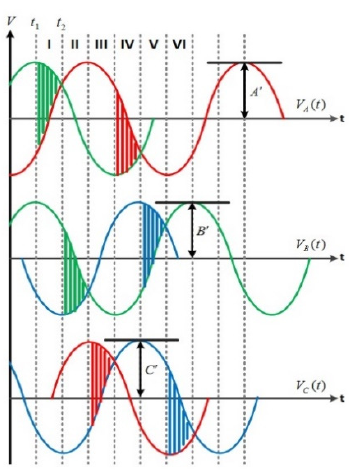
Figure 4. Schematic of the three-phase back EMF of the PMSM.